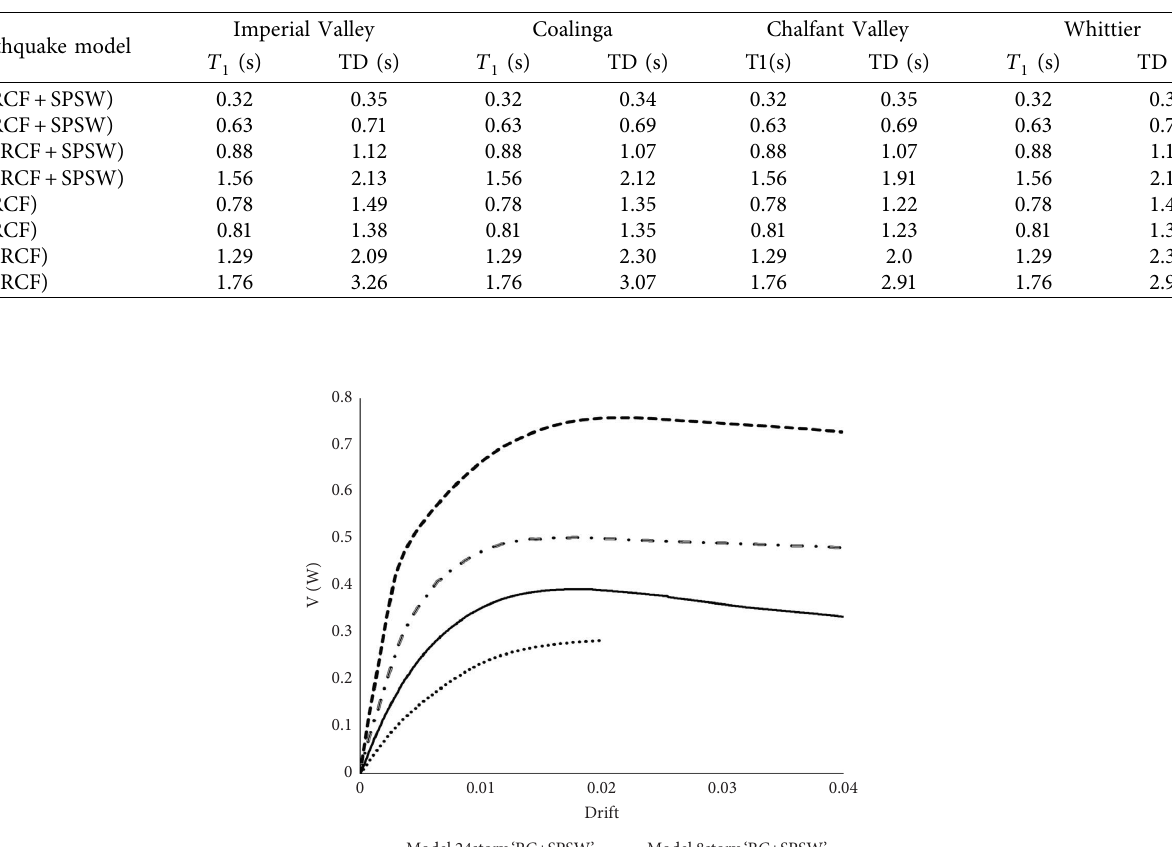
Table 8: Te frst-mode period of vibration and period of damaged of the models under group III.